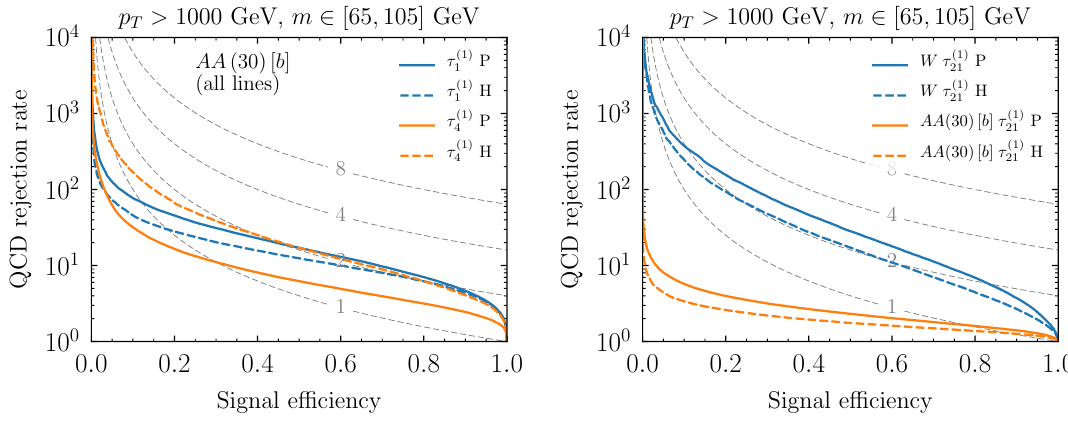
Figure 15 . Comparison of results for selected (cid:28) ( (cid:12) ) (H) and Pythia (P) simulated